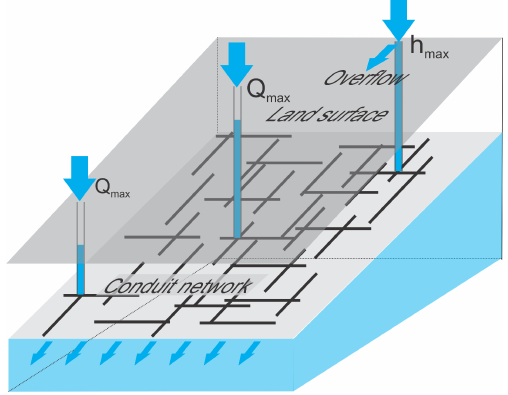
Figure 3. Conceptual framework. A conduit network with point recharge at selected locations indicated by arrows. Recharge is lim- ited by the position of the land surface h max or by maximal available recharge Q max